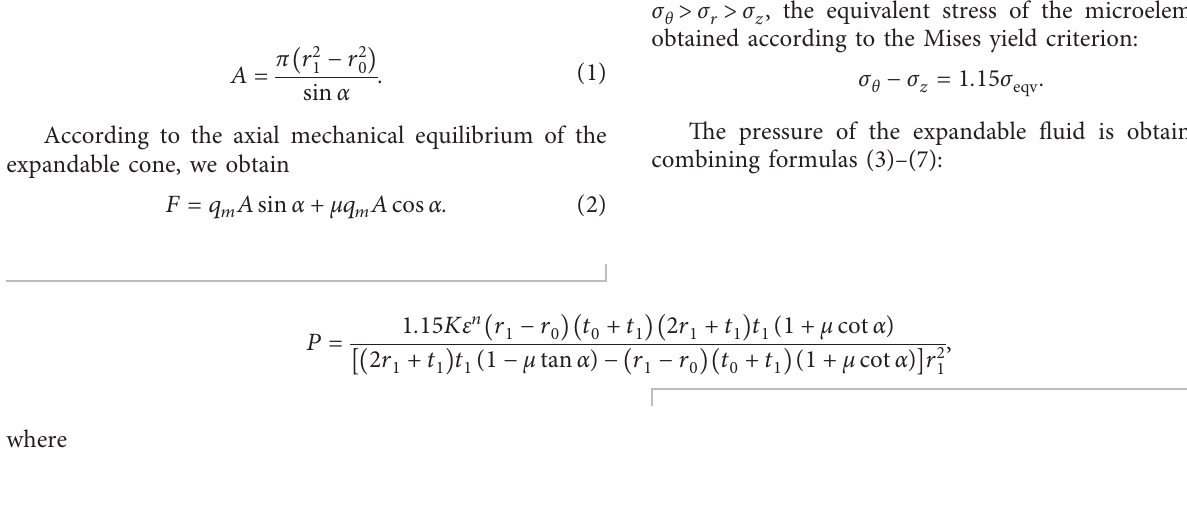
Figure 2: Hanger components of expandable liner